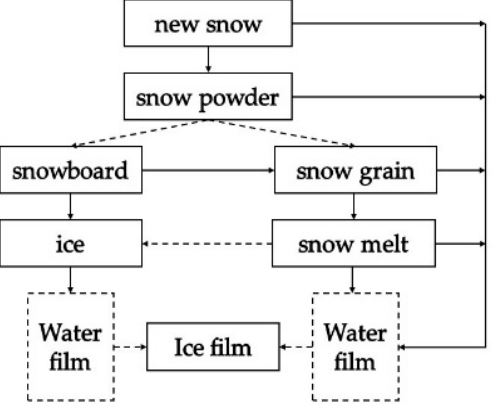
Figure 1. Patterns of snow cover change.